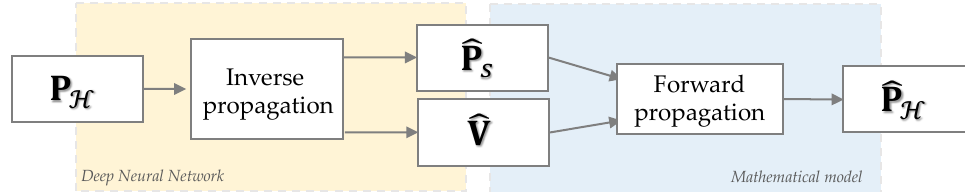
Figure 2. Scheme of the overall two-block scheme proposed to solve the NAH problem. The outputs of the DNN (yellow block) are fed to the forward propagation mathematical model (blue block) in order to get an estimate of the hologram